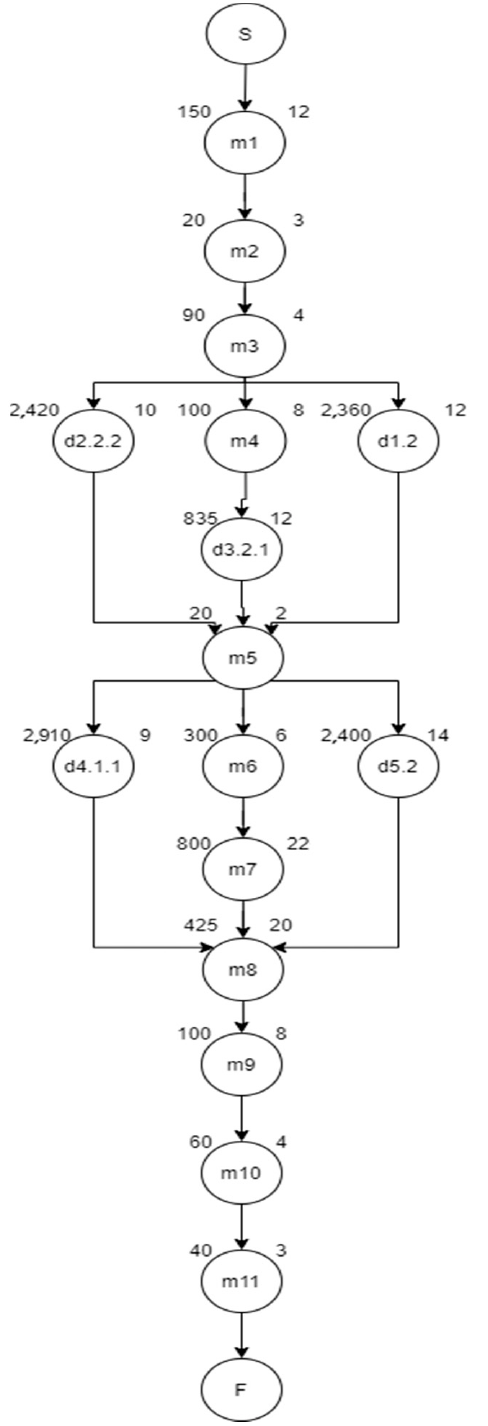
Figure 9. The deterministic graph of option 8 for creating a vertical farm. Source: designed by au- thors.